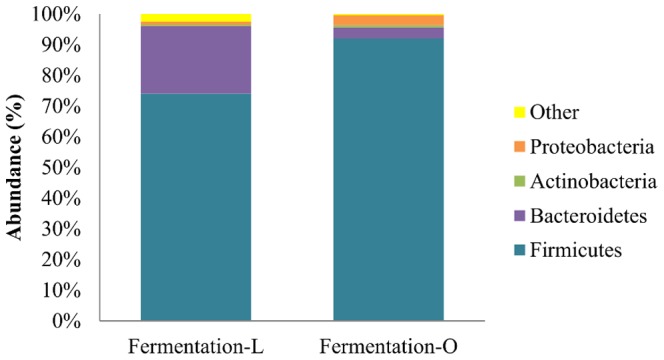
Abundance (%) of Firmicutes, Bacteroidetes, Actinobacteria, Proteobacteria and others.Phyla were analyzed in the fermentations with microbiota from lean (L) or obese (O) subjects at time zero. Data from all runs (fermentation-L n = 11; fermentation-O n = 10) were taken. The category presented as “Other” includes the sum of Verrucomicrobia, Lentisphaerae, Tenericutes and unclassified bacteria which constituted a low abundance in the samples.